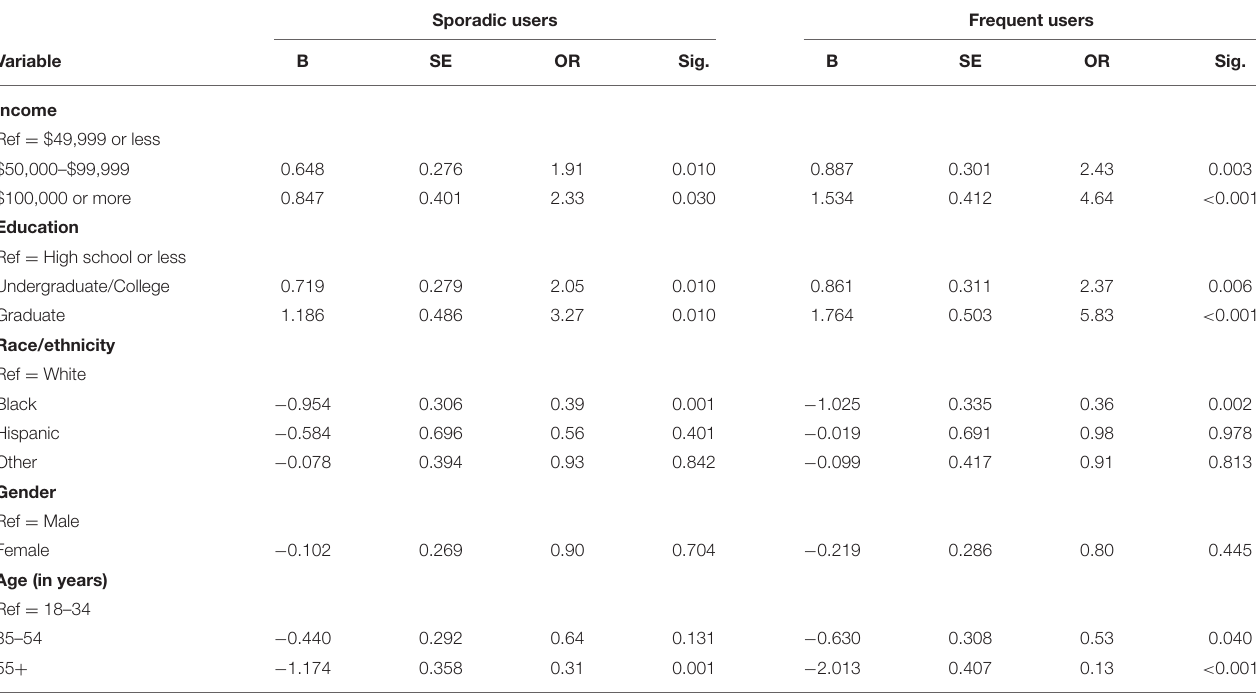
TABLE 2 | Results of multinomial logistic regression model a predicting demographic variables associated with sporadic and frequent park use (relative to non-use) among urban residents ( n = 611) in North Carolina (NC), USA, prior to the COVID-19 pandemic. Sporadic users Frequent users Sig.